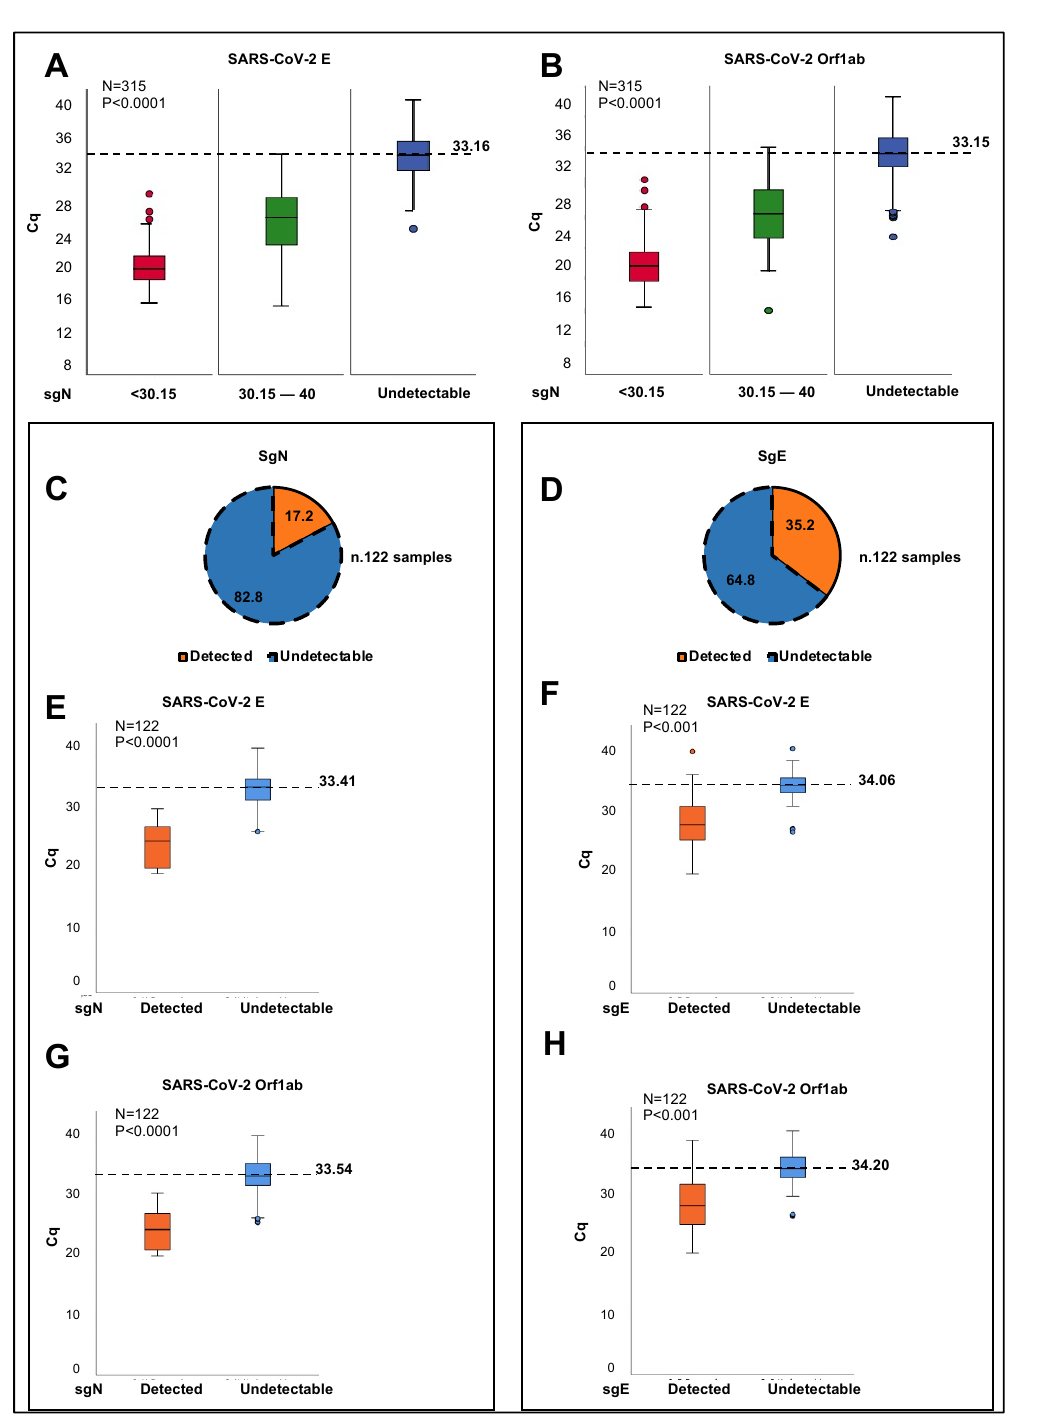
Figure 1. SgN and sgE are detected in samples from COVID ‐ 19 ‐ affected patients with high SARS ‐ CoV ‐ 2 viral load. ( A , B ) Samples obtained from oro/nasopharyngeal swabs from COVID ‐ 19 ‐ positive patients (N = 315) were stratified into three groups according to the median Cq values of sgN (sgN Cq median = 33.51), as detected through SARS ‐ CoV ‐ 2 Viral3 kit. The first group consisted of those samples where Cq for sgN was below the median value (i.e., Cq < 30.51; N = 99 samples; red). The second group was characterized by Cq values for sgN from the Cq median value (30.51) to 40.00 (N = 96 samples; green). The third group comprised samples where sgN was not detected (i.e., Cq > 40; N = 120 samples; blue). An ANOVA was used through IBM SPSS Statistics to determine the cut ‐ off for sgN detection. SgN was detected in the samples with viral E Cq values < 33.163 ( A ) and ORF1ab Cq values < 33.155 ( B ) ( p < 0.0001, for both). ( C , D ) Pie charts showing the proportions (%) of the oro/nasopharyngeal swab specimens where the levels of sgN ( C ) and sgE ( D ) were detectable (i.e.,